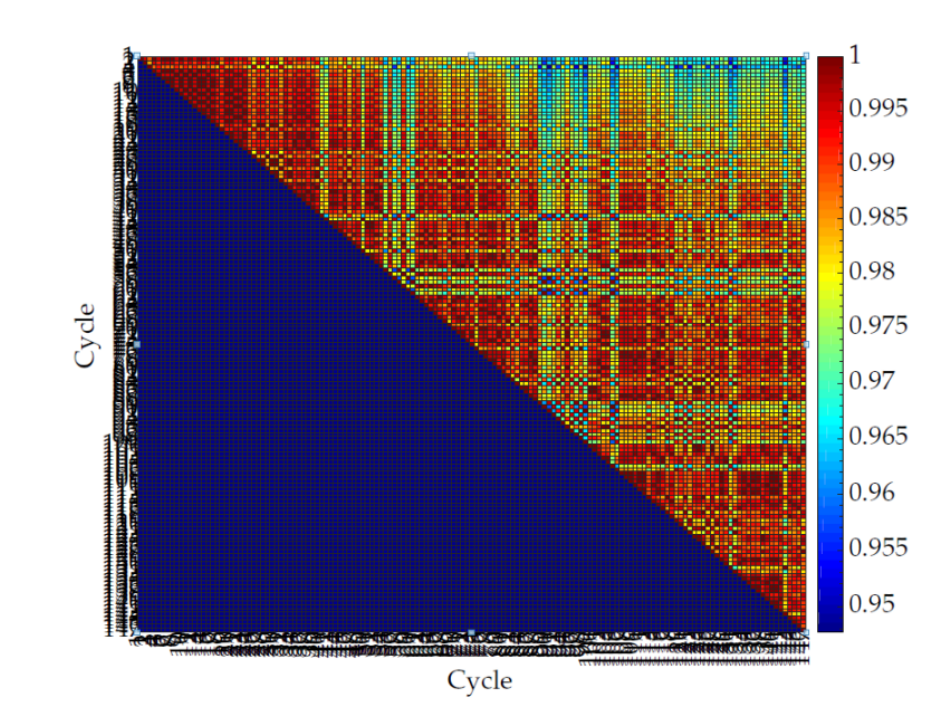
Figure 27. Normalized cross-correlation between sinusoidal motions for a band with a high iteration frequency (30 cycles/min) and high stretch length (14